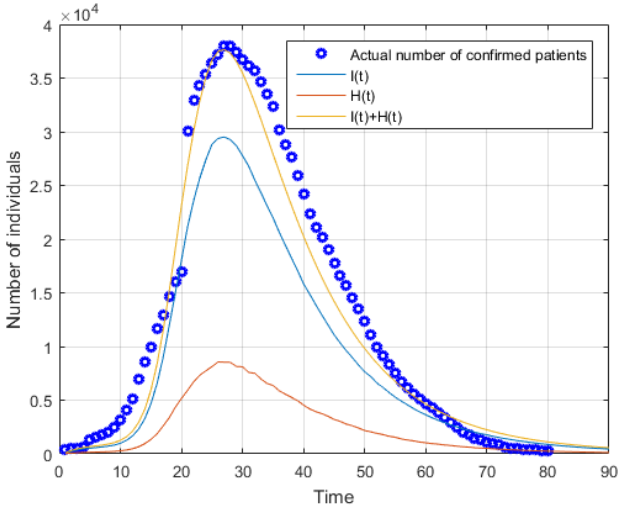
Figure 5. Theoretical estimates of infected patients and the critical patients by the modified SEIR model.